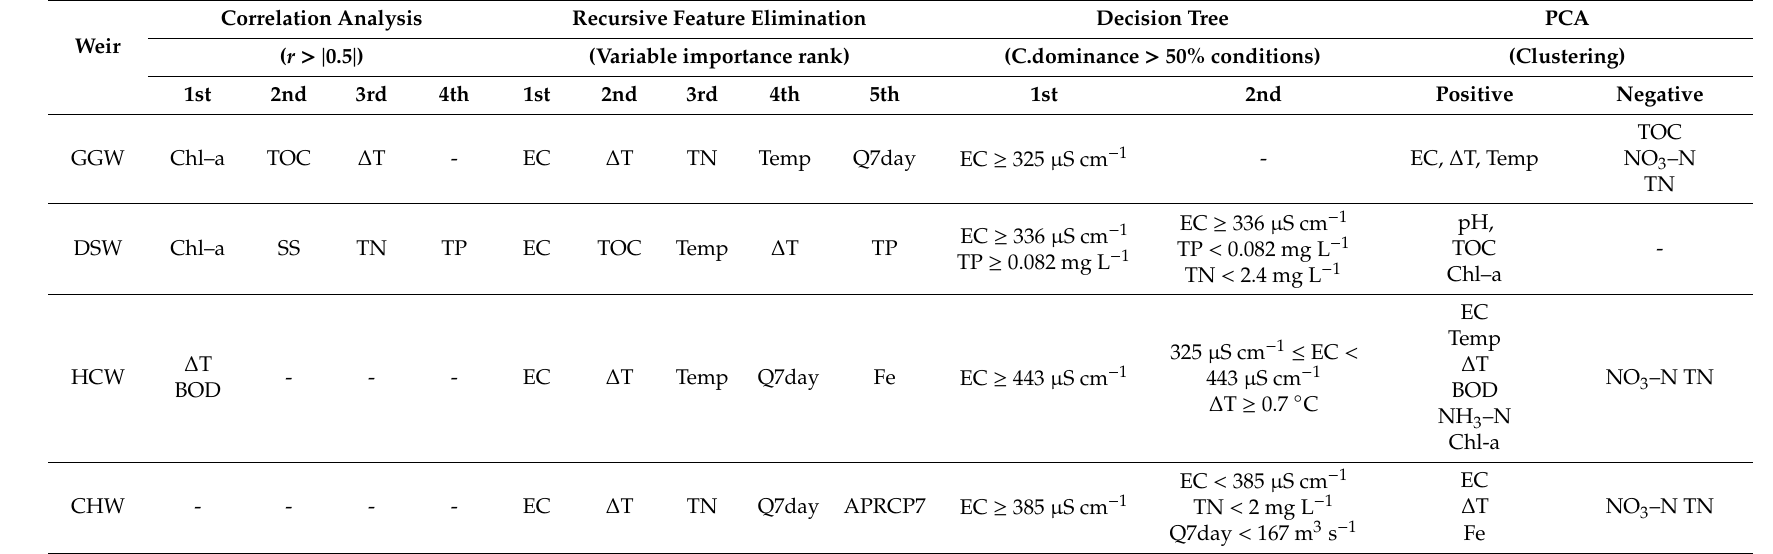
Table 5. Integration of statistical analysis and data mining results for comprehensive interpretation; Gangjeong Goryeong weir (GGW), Dalseong weir (DSW), Hapcheon Changnyeong weir (HCW), and Changnyeong Haman weir (CHW). Note: see the main text for definitions of abbreviated variables.